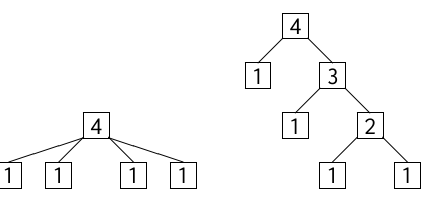
Fig. 1: Partition Trees for Iterative and Recursive WHT